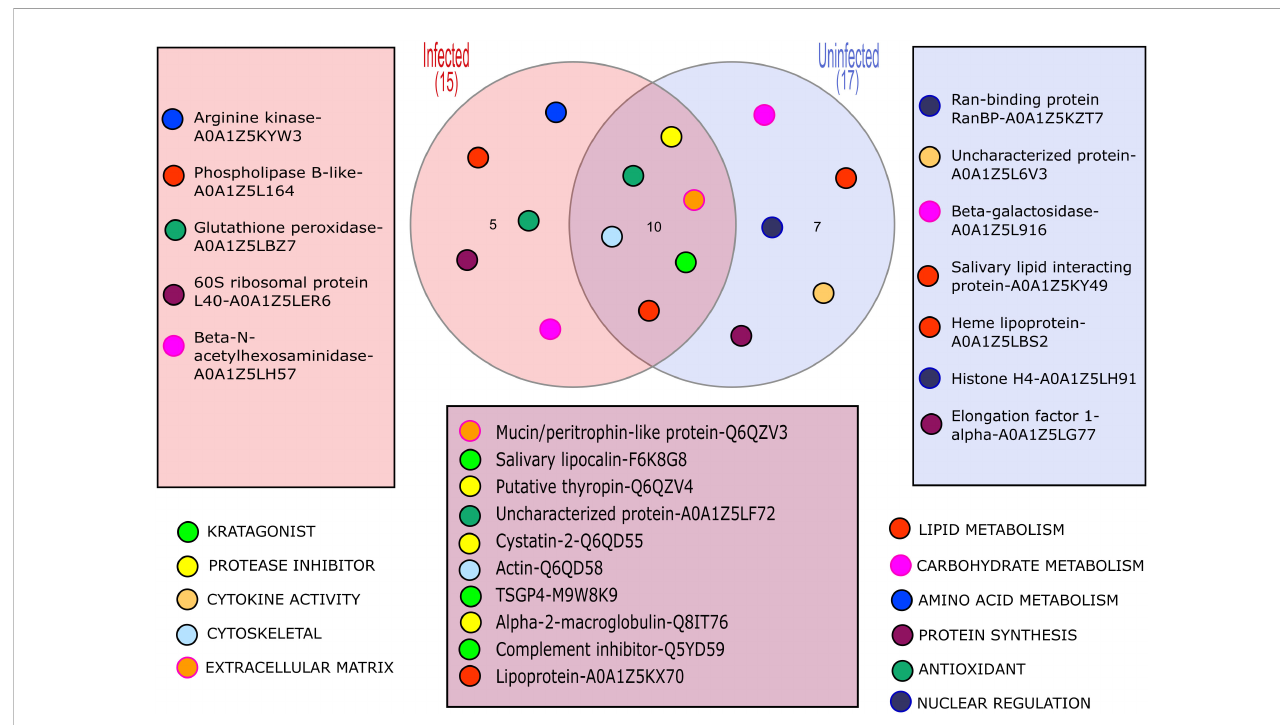
FIGURE 1 A Venn diagram showing the different proteins detected in samples from B . duttonii infected vs uninfected ticks, and their hypothetical functions.